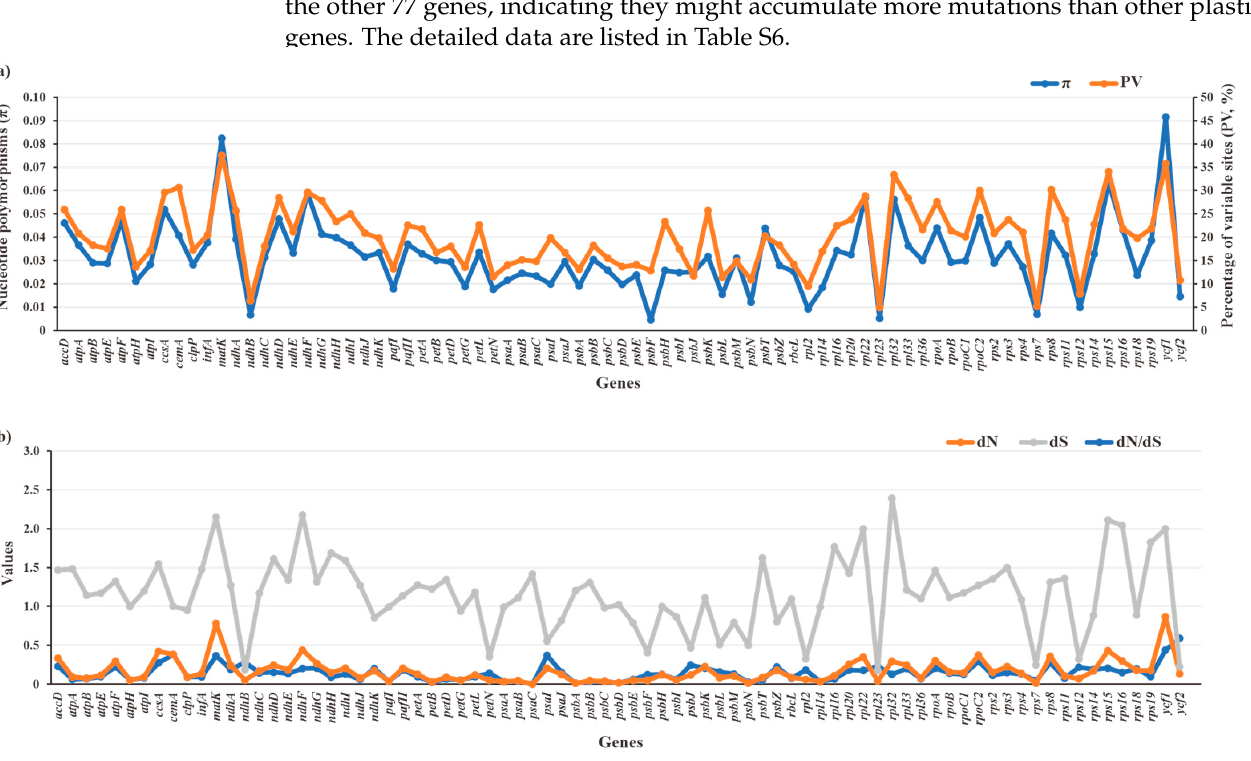
Figure 9. Sequence polymorphism among 79 PCGs of 87 Crassulaceae species. ( a ) Nucleotide diversity ( π ) and percentages of variable sites (PV). ( b ) Estimations of nonsynonymous (dN) and synonymous (dS) substitution rates and the dN/dS.